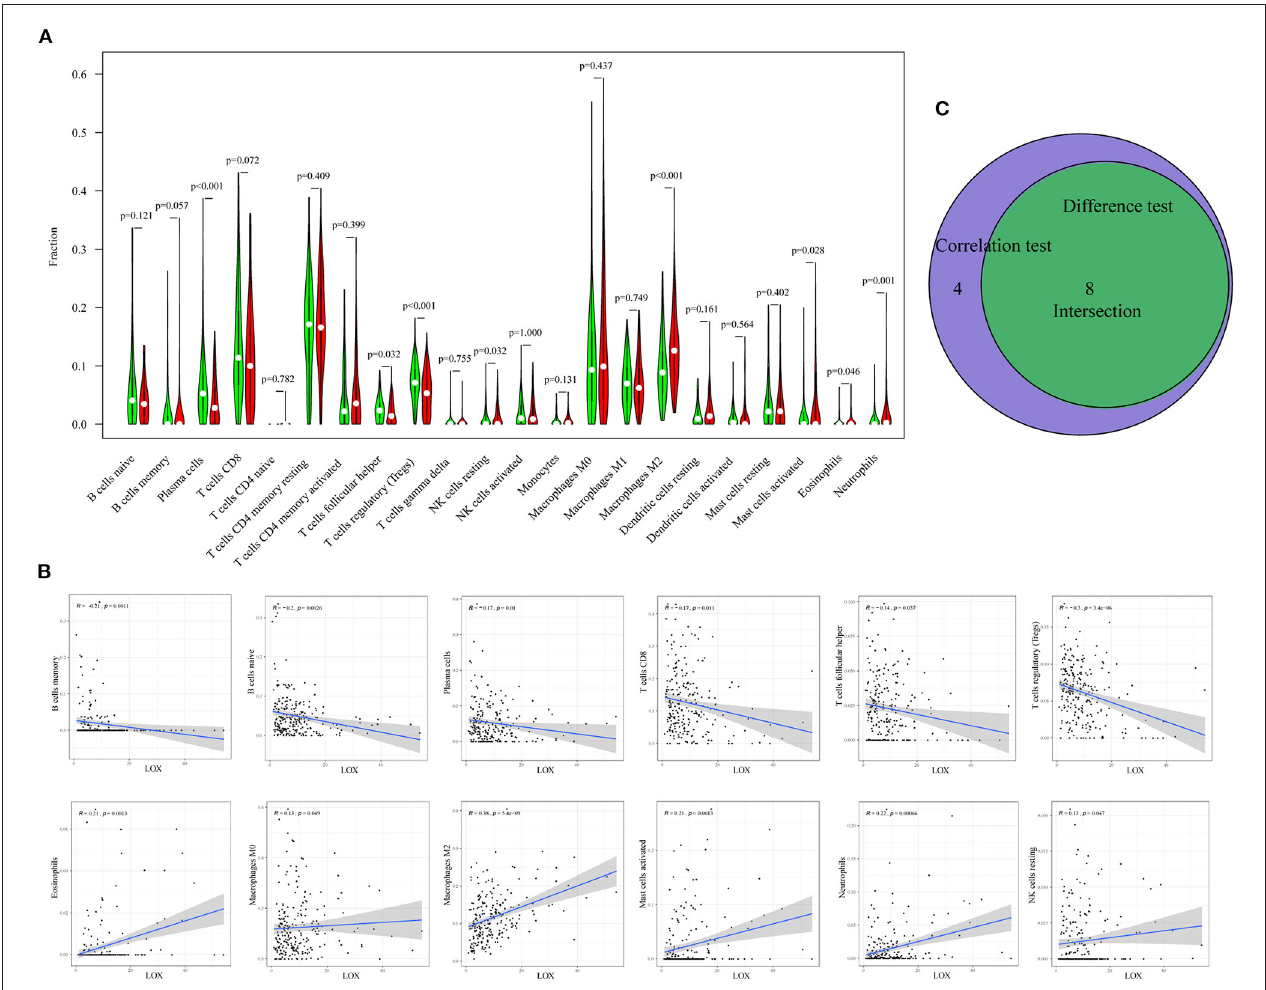
FIGURE 8 | Correlation between TIC ratio and LOX expression. (A) The violin chart shows the proportional difference between the LOX high and low expression groups and 22 TICs (Wilcoxon rank-sum test). (B) The Scatter diagram shows the correlation between LOX expression and the proportion of TIC in 12 (Pearson coefficient test). (C) Venn diagram shows that 8 TICs are related to LOX expression. The intersection of the difference and correlation test is shown in the violin chart and the scatter